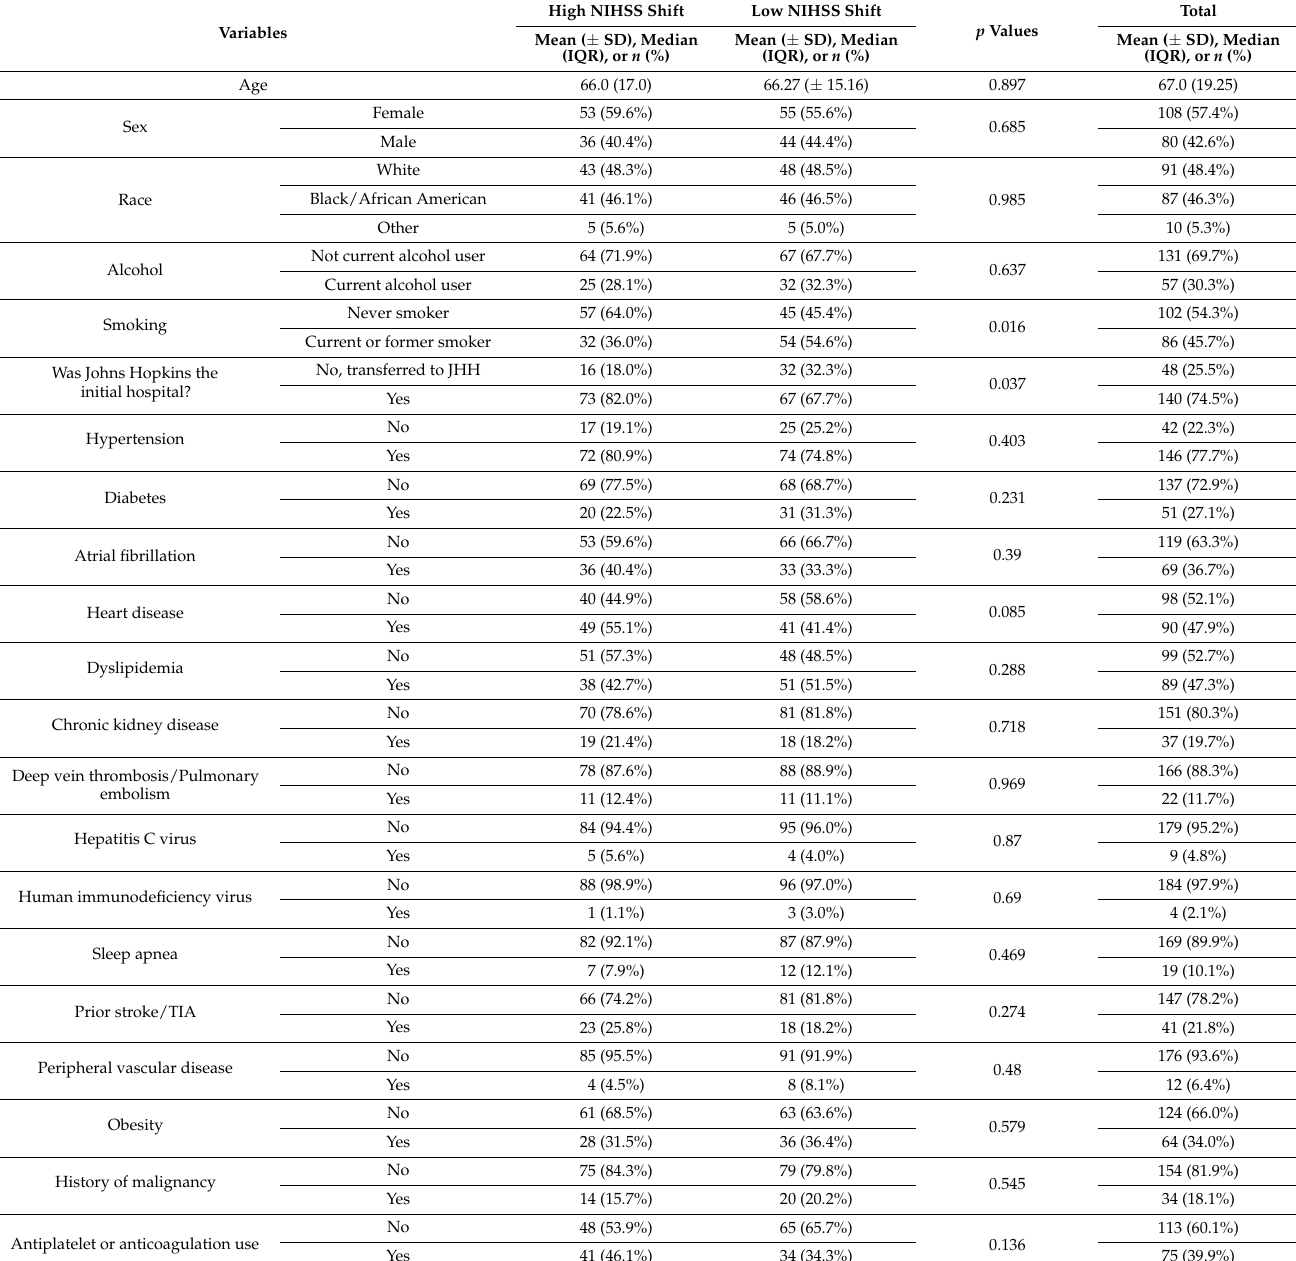
Table 3. The characteristics of the patient population utilized in NIHSS shift